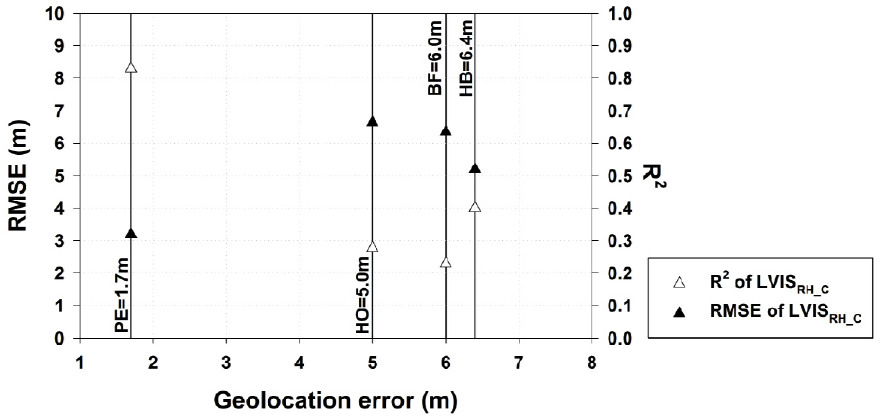
Figure 7. Impact of geolocation errors on overall accuracy of LVIS height retrieval. This comparison includes Bartlett Experimental Forest (BF), Howland Research Forest (HO), Hubbard Brook Experimental Forest (HB), and Penobscot Experimental Forest (PE) sites only (where geolocation accuracy assessments were